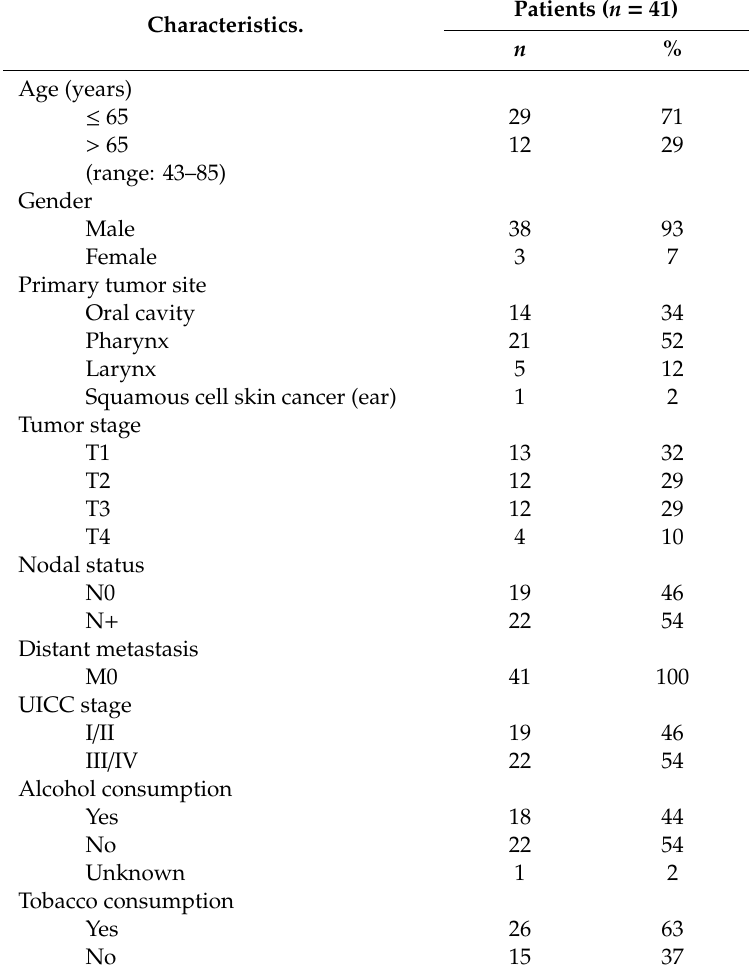
Table 1. Patient